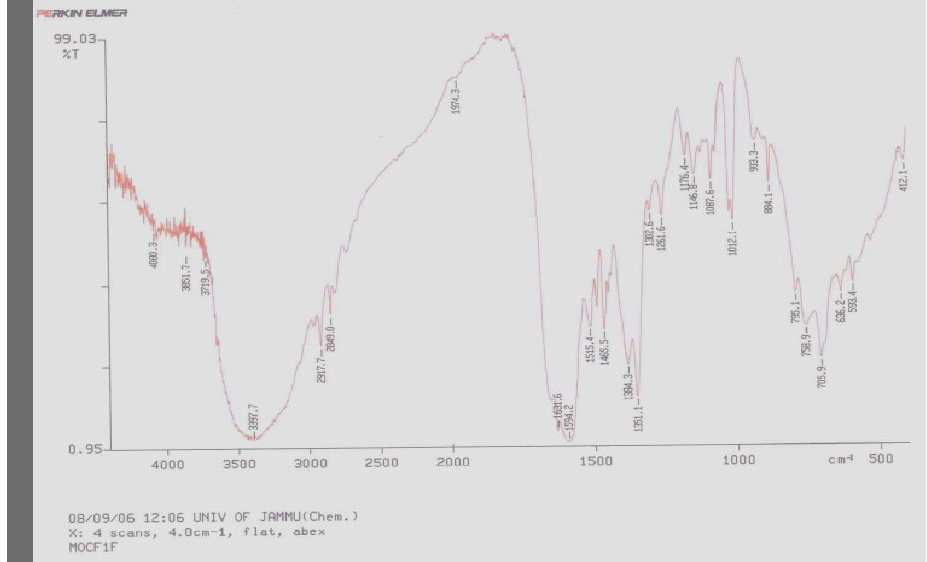
Figure 1. IR spectrum of [Mo(CO)